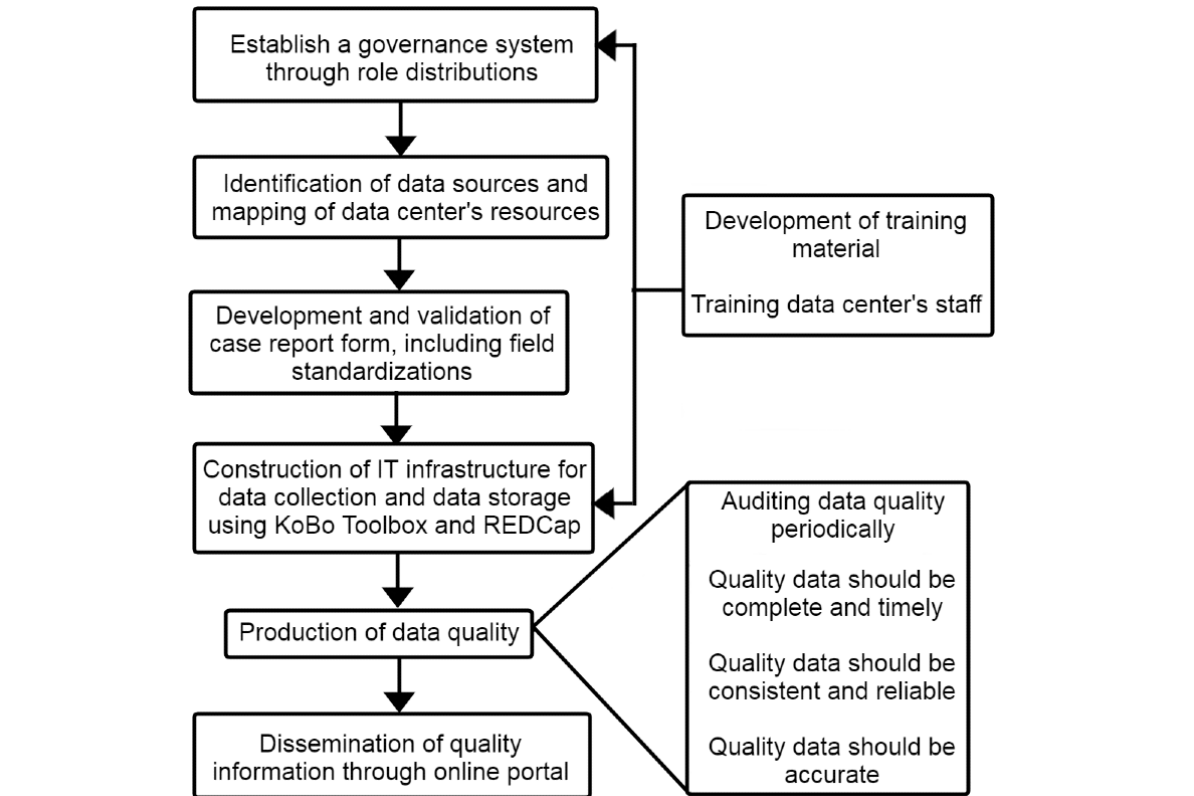
Figure 1. Framework for quality management of rare disease registries. IT: information